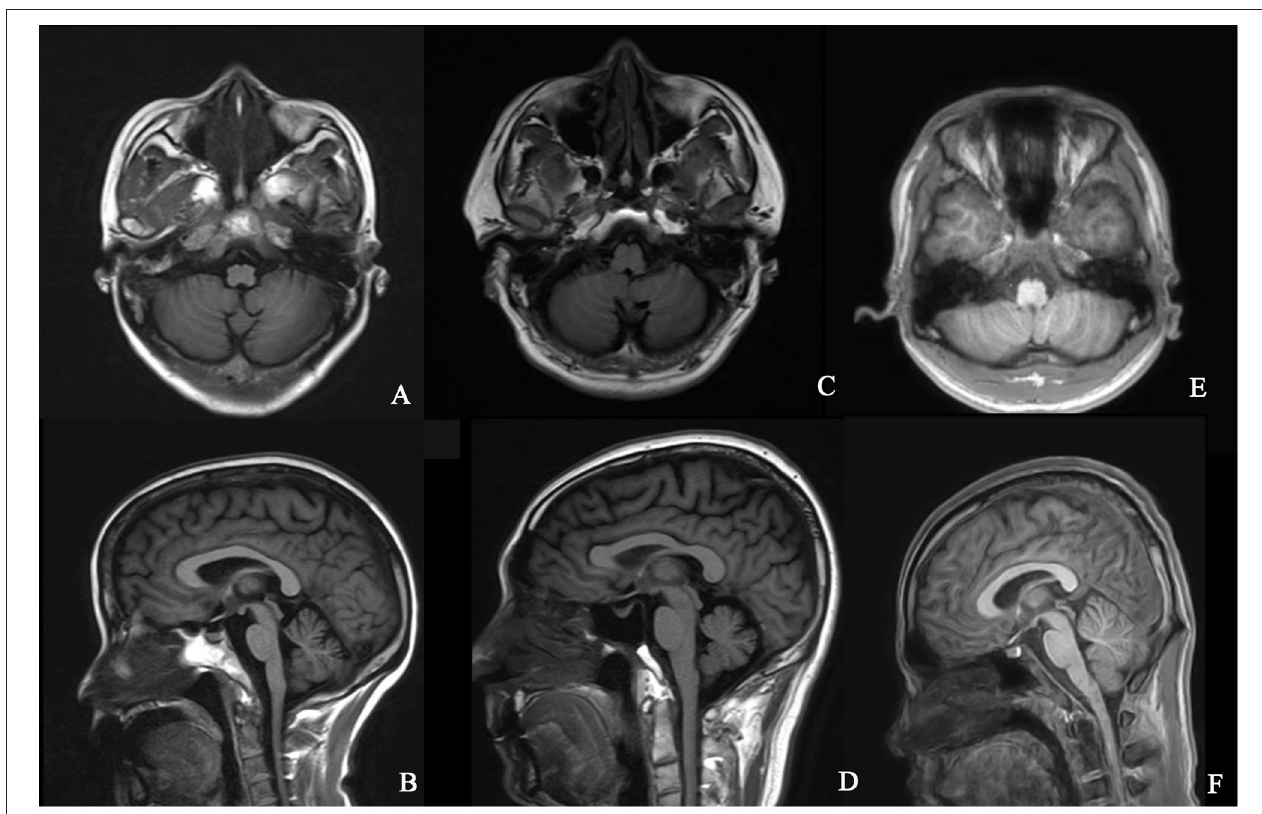
FIGURE 5 | Brain MRI in patients with SCA3, SCA17, and SCA28. T1 axial and sagittal images showing cerebellar atrophy in a 40-year-old female patient with SCA3 (A,B) . T1 axial and sagittal images showing cerebellar atrophy in a 50-year-old male patient with SCA28 (C,D) . No specific sign of cerebellar atrophy was found in T1 axial and sagittal images of a 17-year-old male patient with SCA17 (E,F)